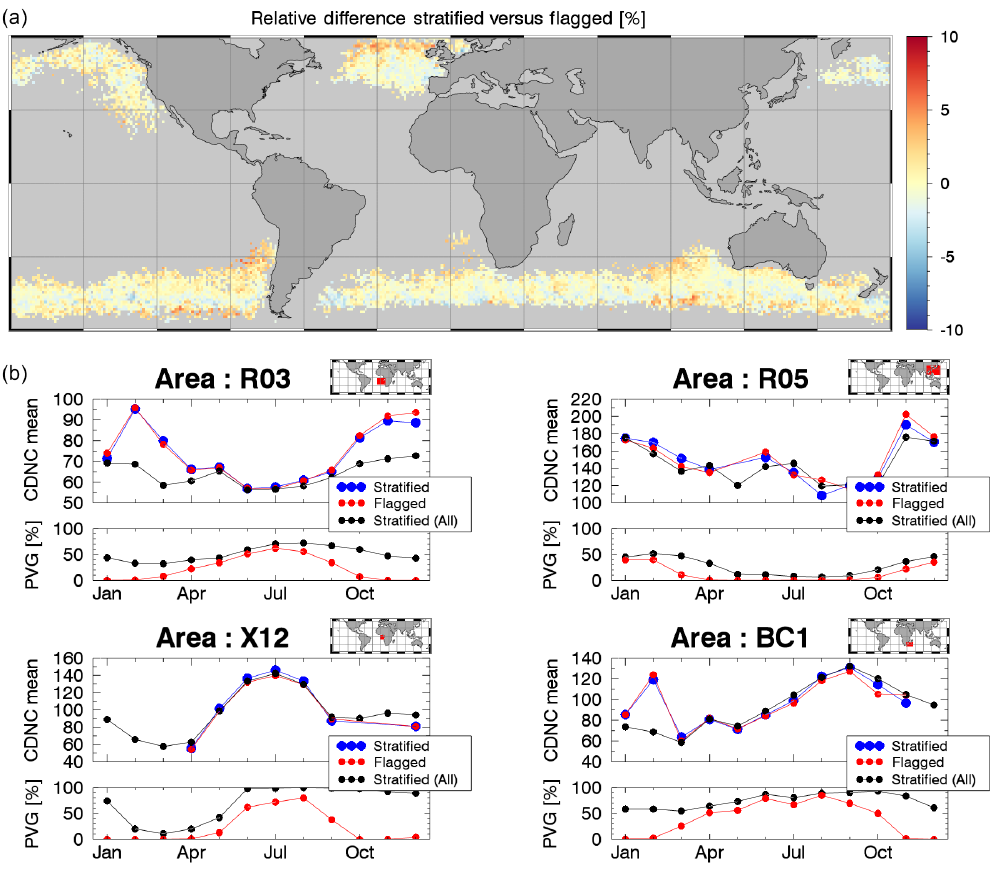
Figure 6. Same as Fig. 5 but for “Stratified” versus “Flagged”; see Table 1 for terminology. For details on the selected regions, see